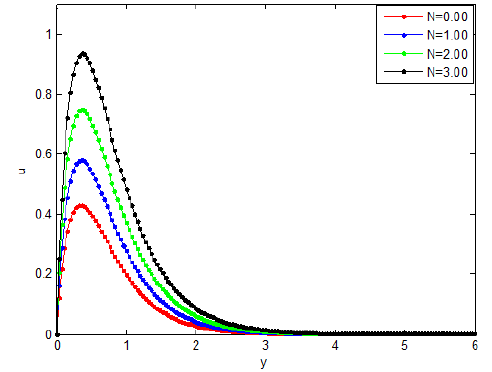
Figure 19. Effects of buoyancy ratio on the velocity